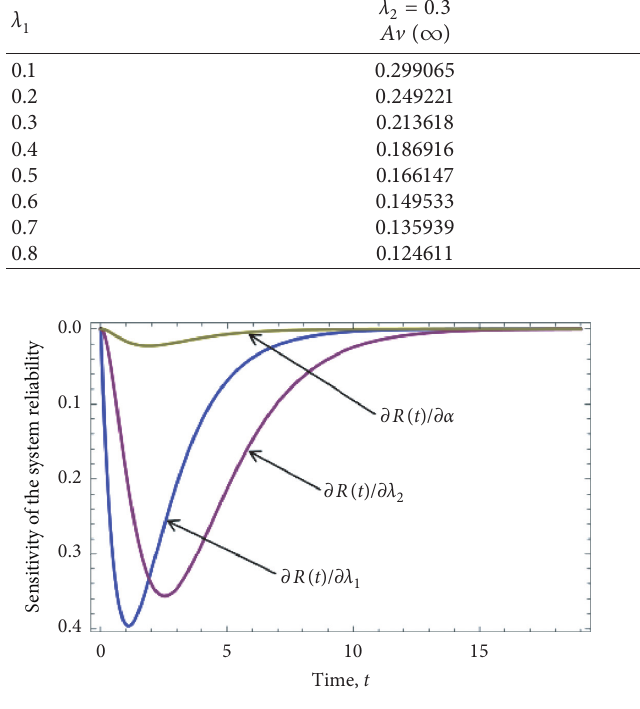
and λ when ( α � 0 . 6 , β 1 1